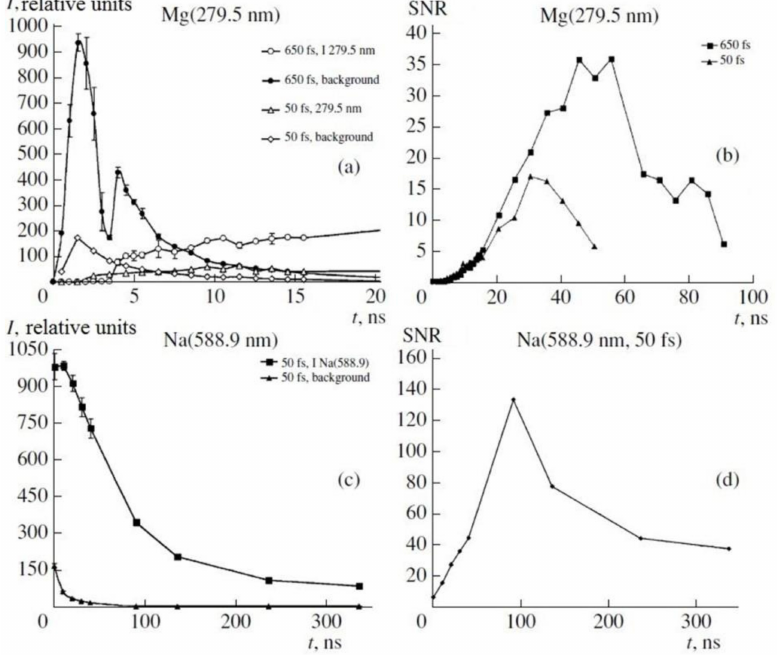
Figure 9. Time dependence of line intensity and background intensity for Mg (279.5 nm) ( a ) and Na (588.9 nm) ( c ) lines; time dependence of contrast K for Mg (279.5 nm) ( b ) and Na (588.9 nm) lines ( d ).